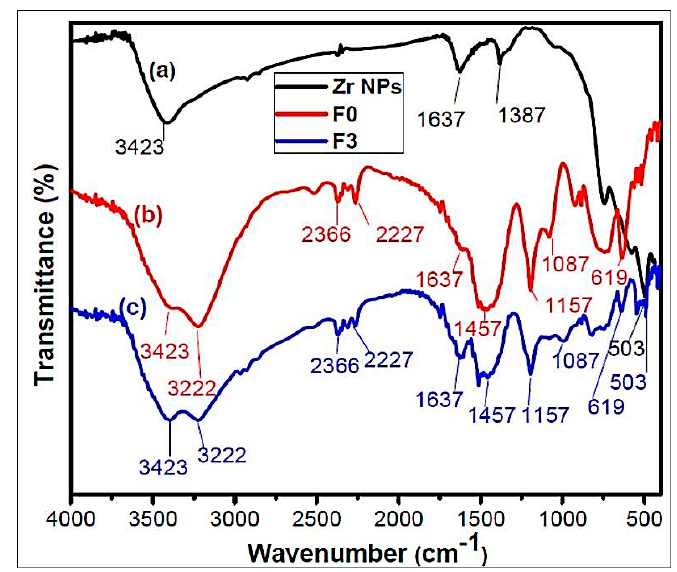
Figure 6. FT-IR spectra of ( a ) Pure Zr NPs, ( b ) F0, and ( c ) F3 samples.